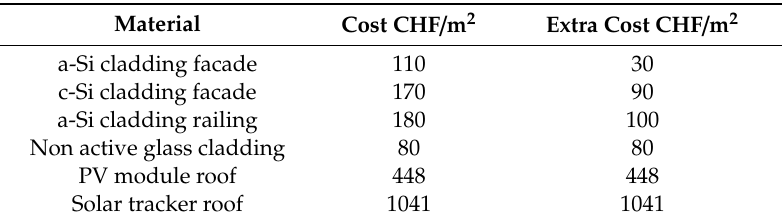
Table 3. Extra cost of BIPV